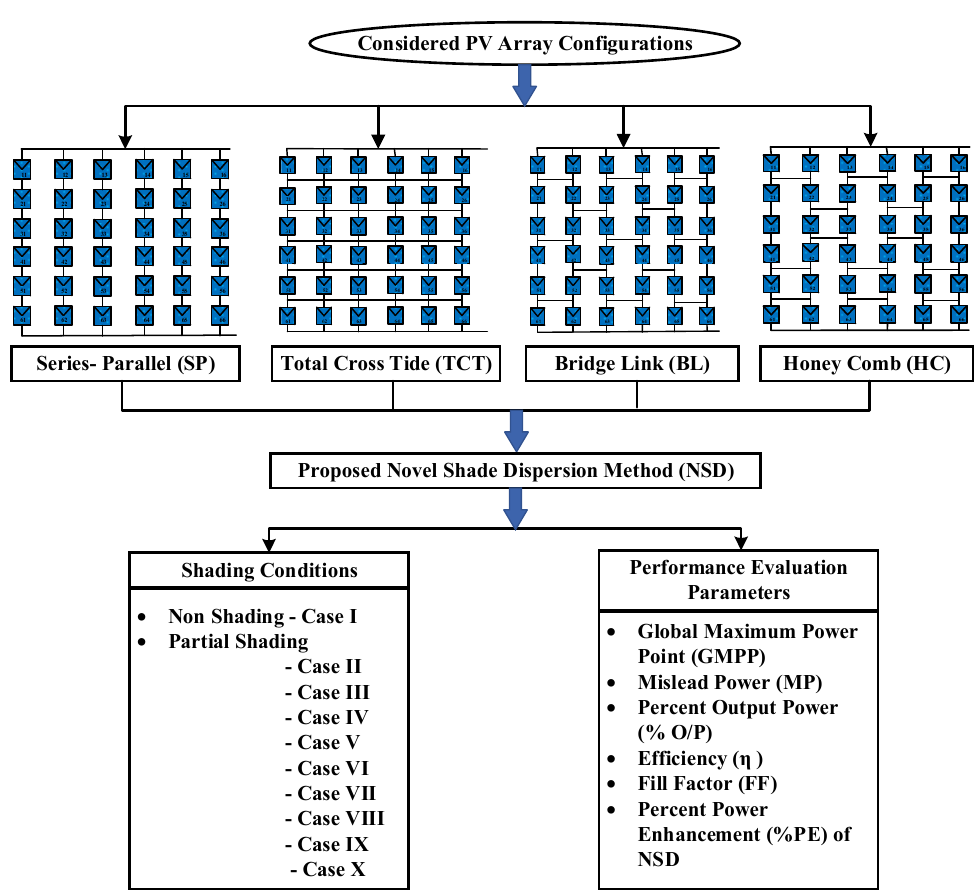
Figure 1. Representation of PV array connection structures under partial shading conditions with performance evaluation